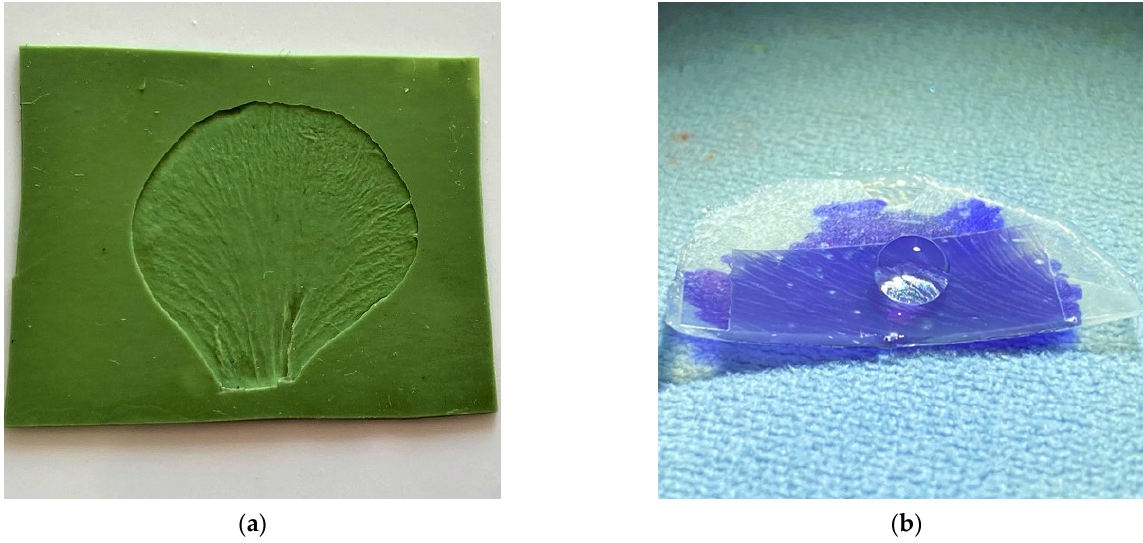
Figure 4. Replication results. ( a ) First (negative) replica—elastomeric mold. ( b ) Second (positive) replica—sample made of semi–crystalline polymer—drop of water on the surface demonstrating the hydrophobicity of the surface.